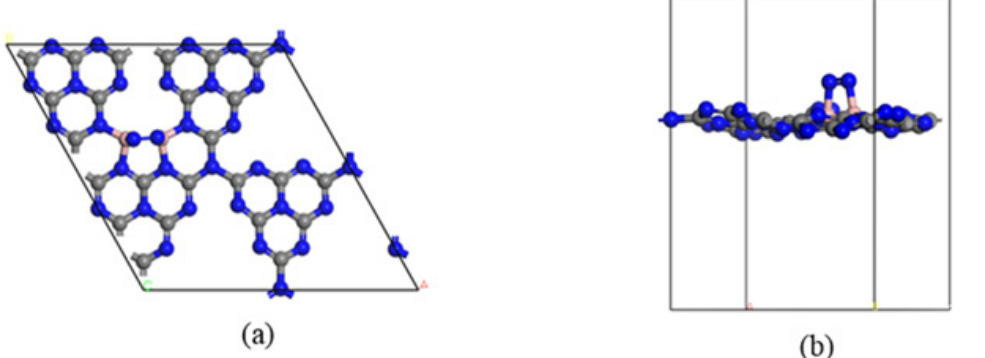
Figure 1. ( a ) Top and side views of the atomic configurations of g-C 3 N 4 . ( b ) The structure of double B atoms embedded in the g-C 3 N 4 monolayer. Blue, gray, and pink balls represent the N, C, and embedded B atoms, respectively.